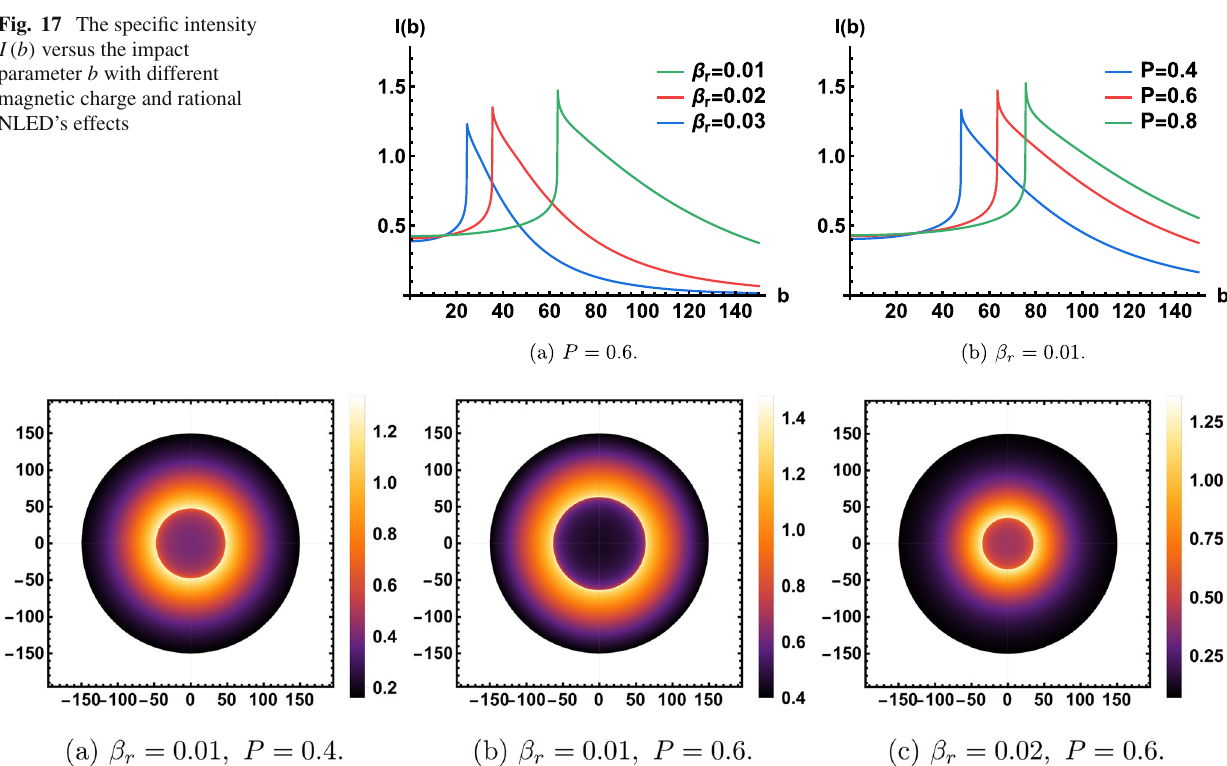
Fig. 17 The specific intensity I ( b ) versus the impact